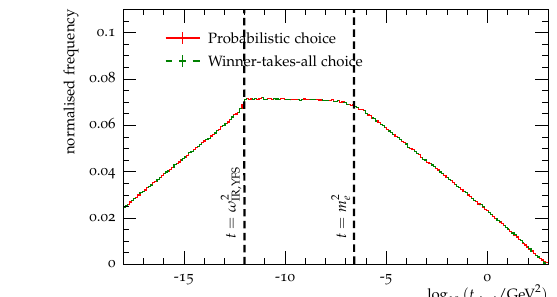
e ± γ splitting. Right: → using either a T , start , and e